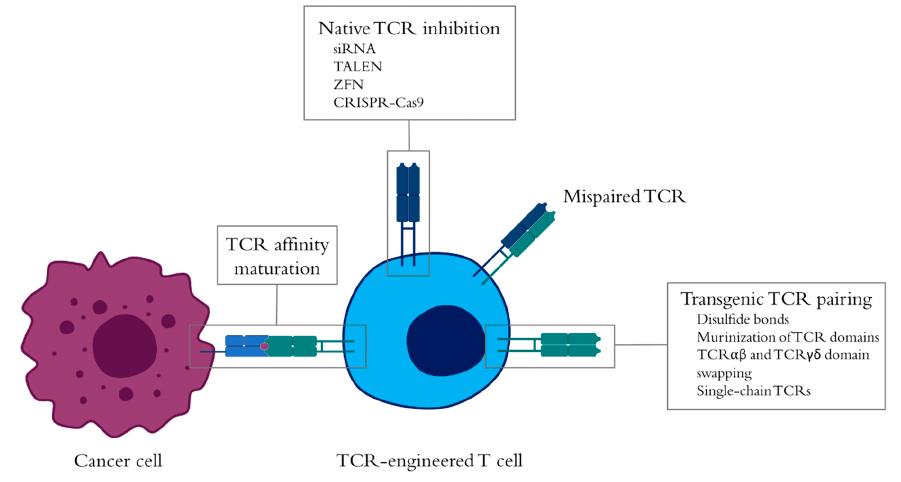
Figure 2. Enhancement of tumor-specific T-cell receptor (TCR)-engineered T cells. The antitumor functionality of TCR-engineered T cells can be leveraged by improving the affinity of the TCR – peptide-major histocompatibility complex (pMHC) interaction via TCR affinity maturation processes,